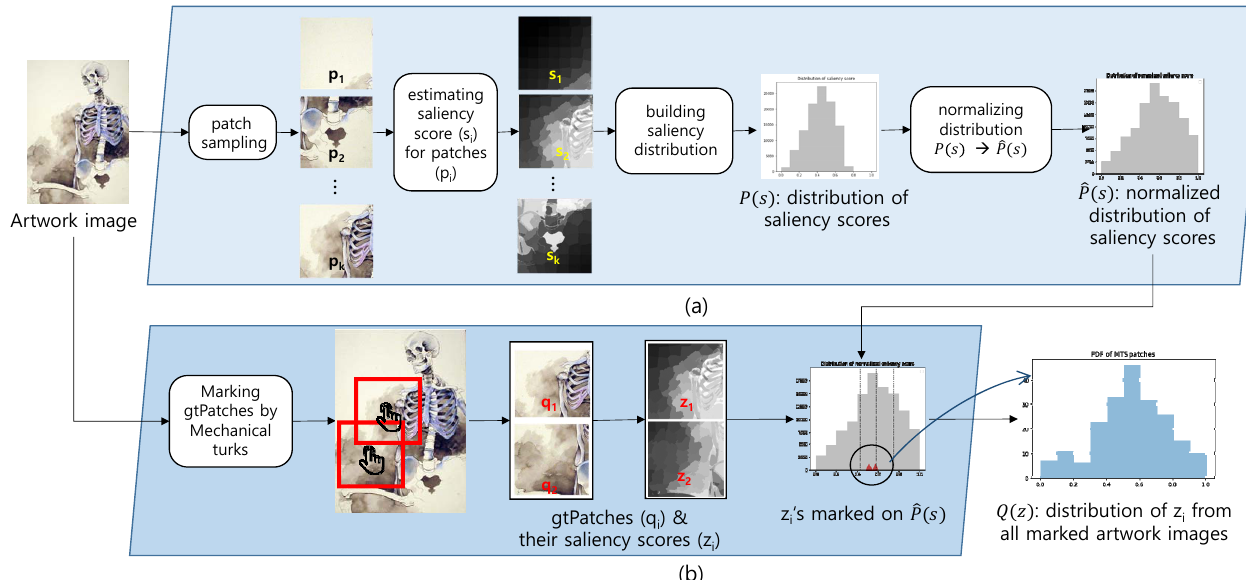
Figure 1. Two processes to build our saliency-based patch sampling scheme: ( a ) building the distribution of saliency scores for an input artwork image, ( b ) building the distribution of saliency scores for a